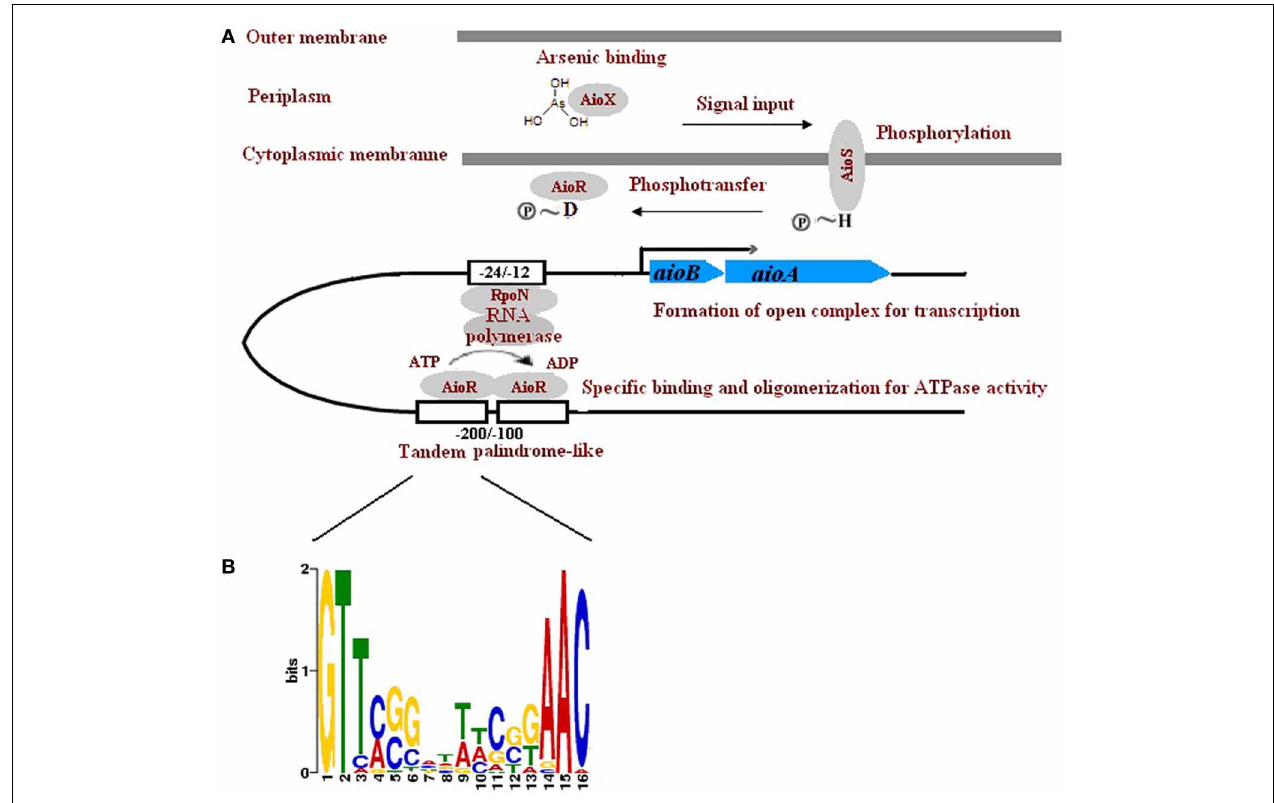
FIGURE 5 | A proposed mechanism aioXSR mediated aioBA regulation. (A) AioX binds to arsenite and delivers the signal to the AioS/AioR two-component system. The phosphorylated AioR binds to the palindrome-like sequence, leading to oligomerization for ATPase activity.